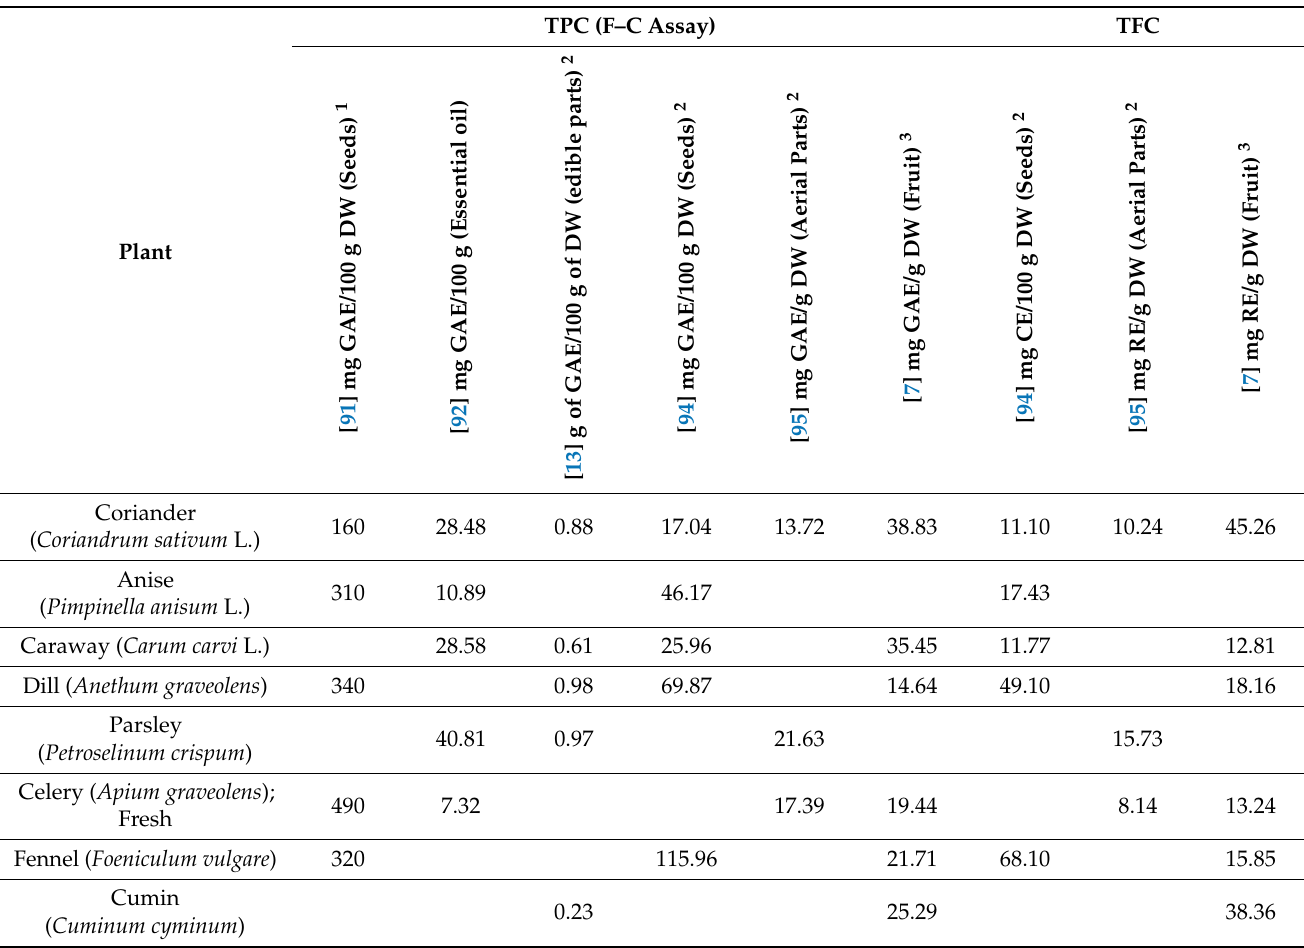
Table 4. The TPC and TFC of common plants of Apiaceae